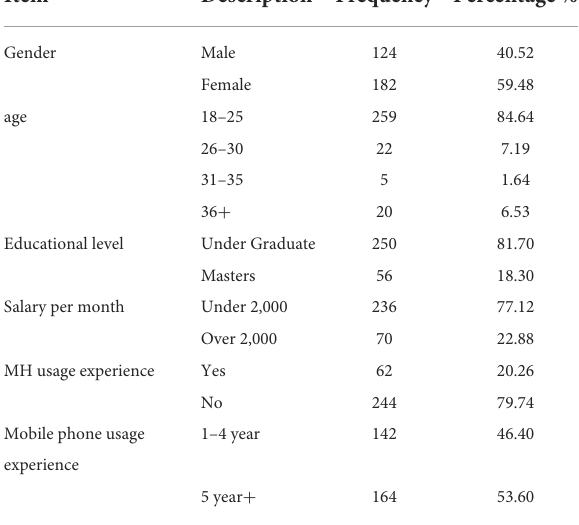
TABLE 2 Respondent demographic